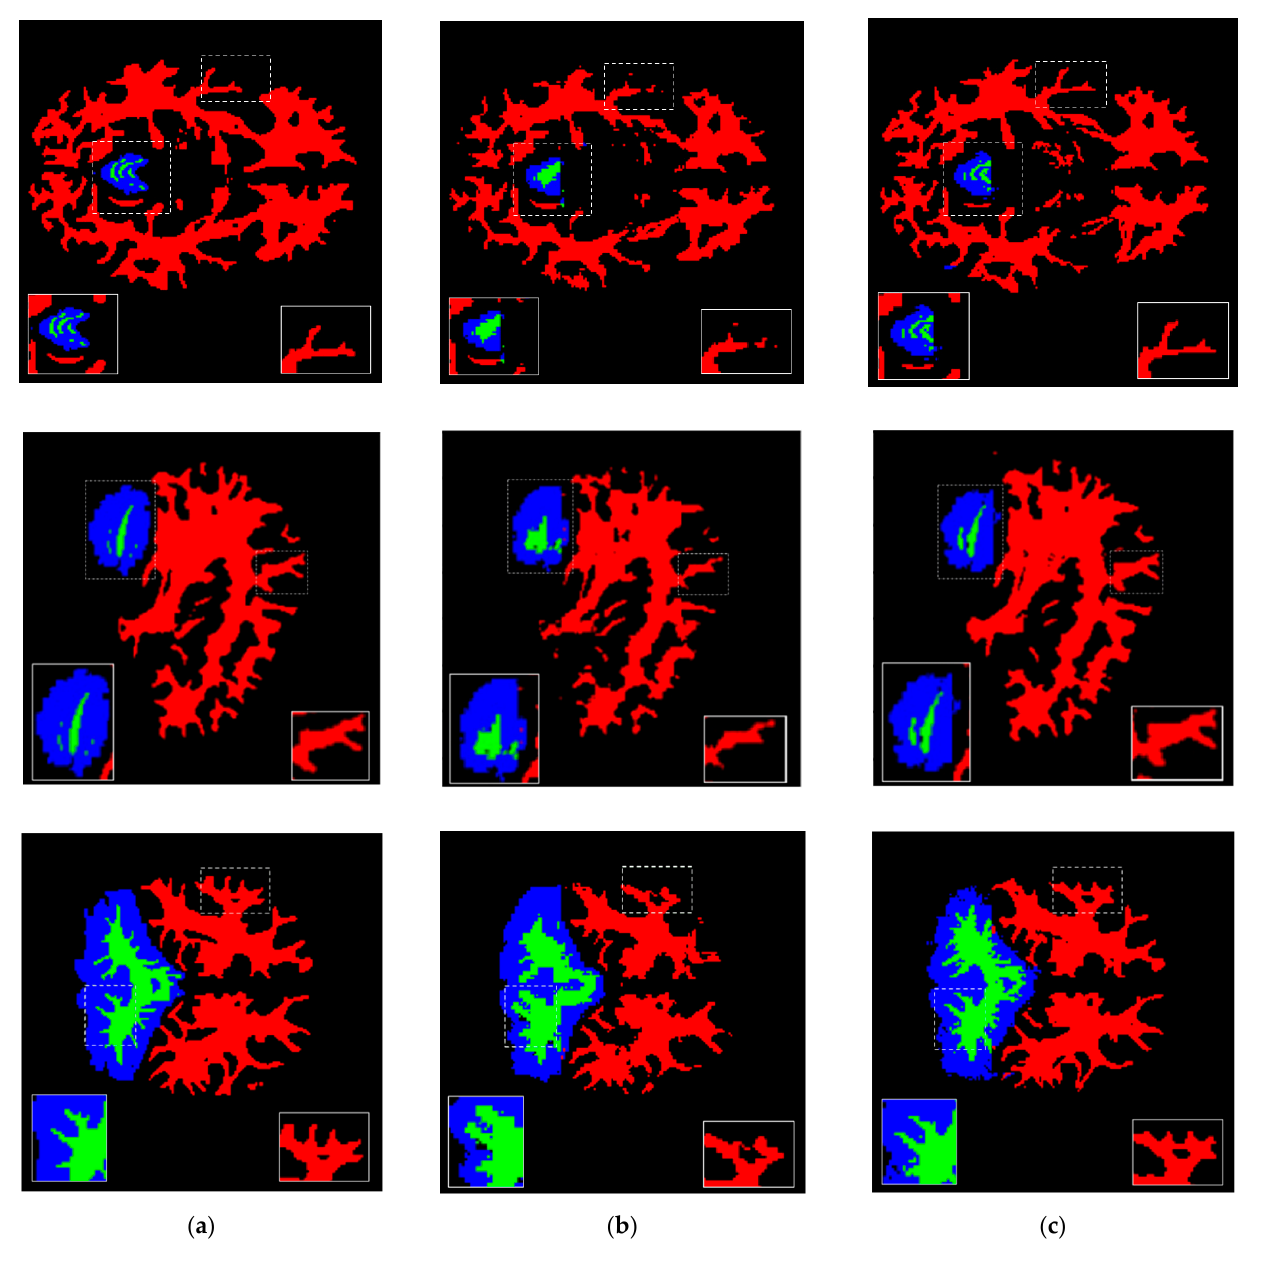
Figure 6. Patch size influence comparison on structure details segmentation in the axial, sagittal and coronal planes where red, green, and blue colors represent cerebral white matter, cerebellum white matter and cerebellum cortex structures, respectively. ( a ) Ground truth mask; ( b ) segmentation with patch resolution size of 16 × 16 × 16 ; ( c ) segmentation with patch resolution size of 8 × 8 × 8 .